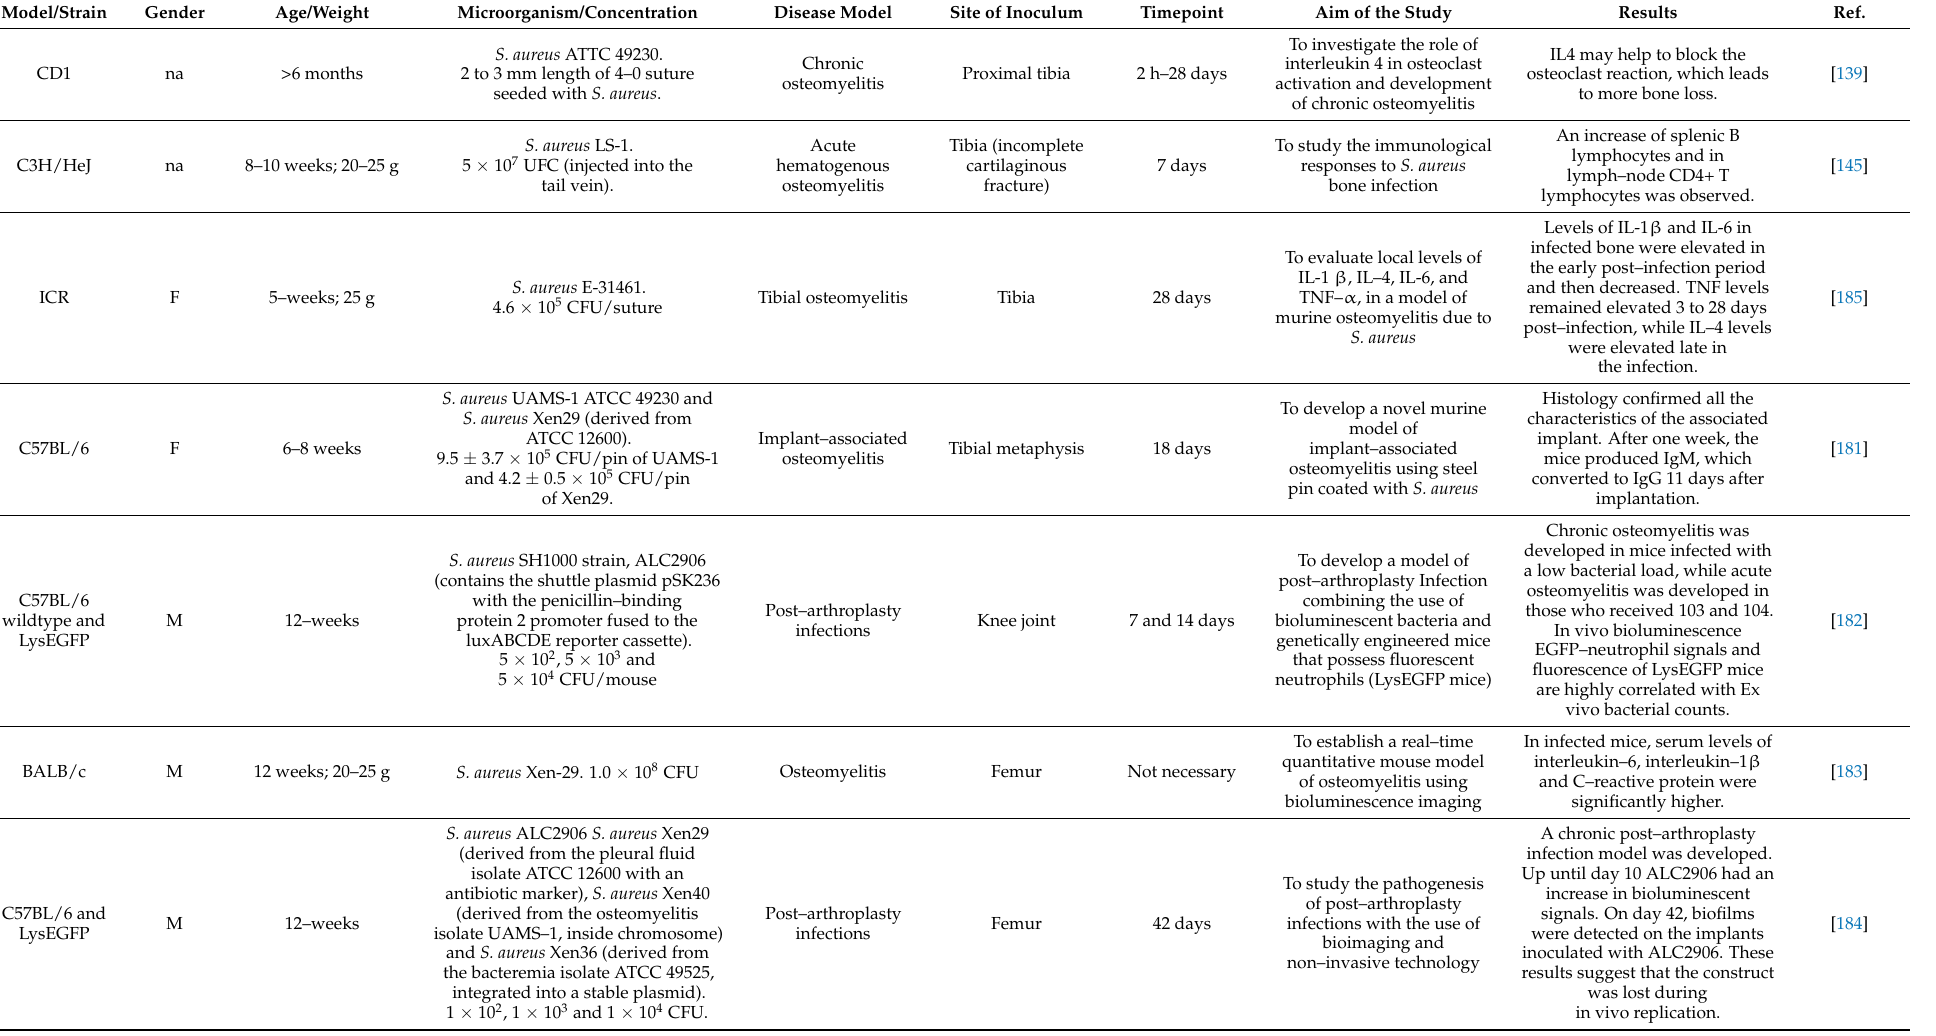
Table 3. Mouse models of orthopedic